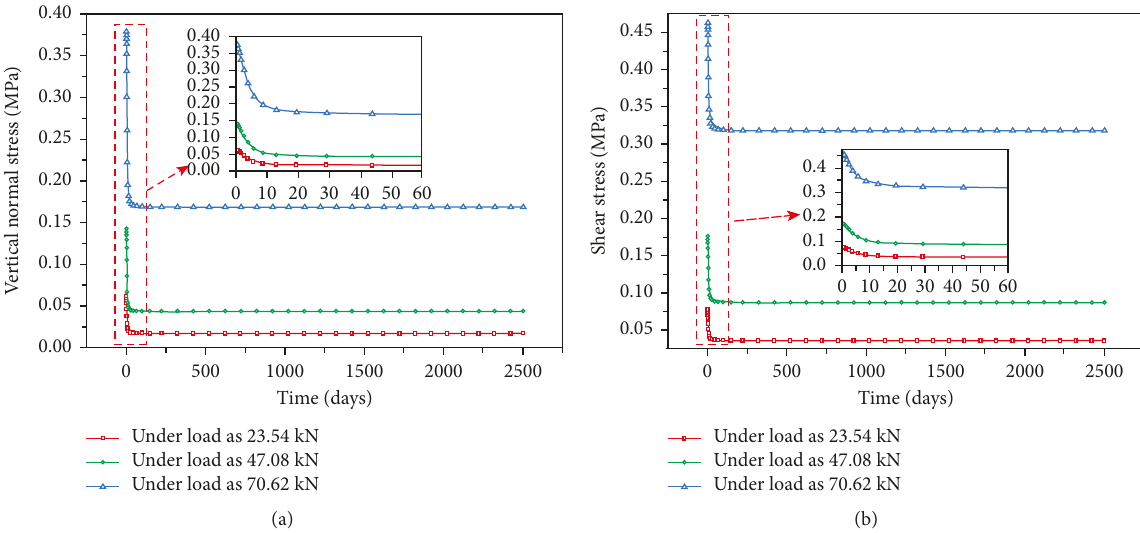
Figure 13: The separate effect of shear creep of adhesive on the edge stresses. (a) Variation of vertical normal stress with time. (b) Variation of shear stress with time.